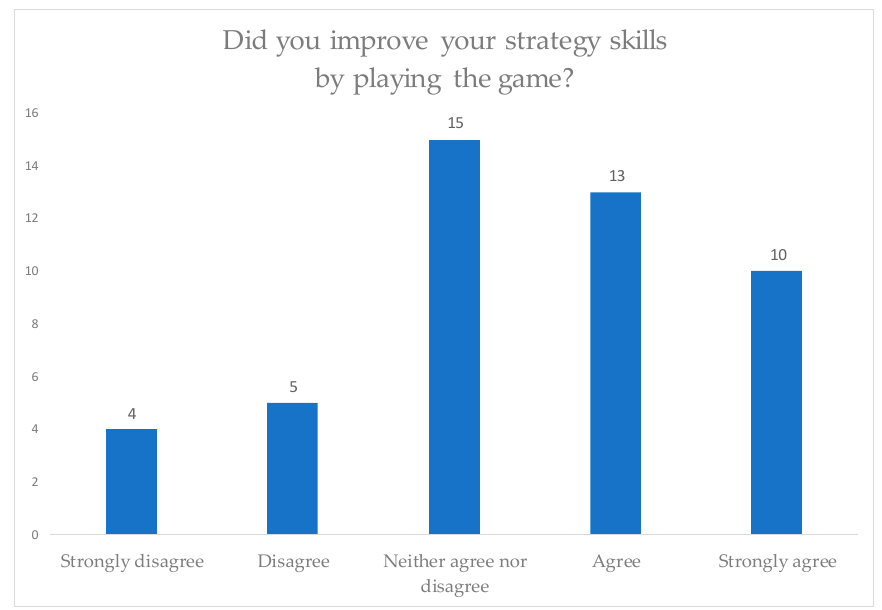
Figure 7. Questionnaire results regarding students’ perception of gameplay strategy improvement.